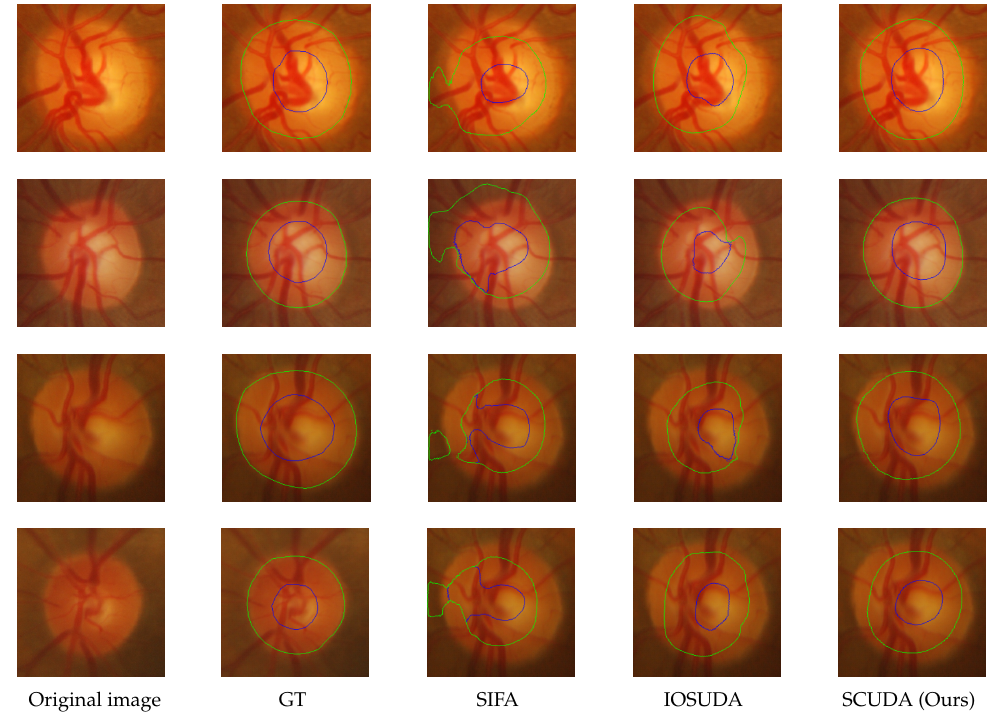
Figure 8. Representative visual examples of the Drishti-GS test set; the green contours indicate the boundary of the optical disc and the blue contours indicate the boundary of the optic cup. From the left to right: original images, GT, and the results of SIFA, IOSUDA, and our proposed